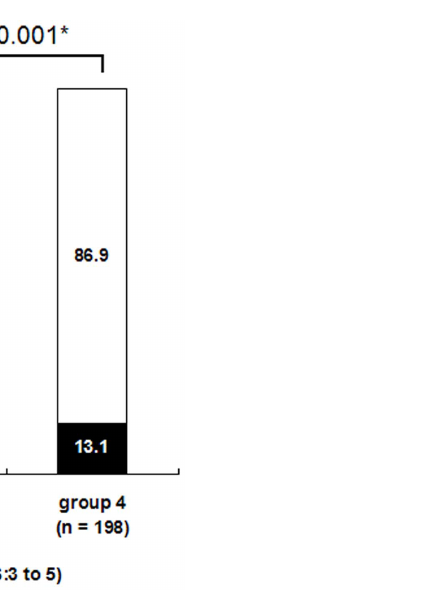
Figure 3. Percentage plot displaying percentages of unfavorable outcome in four subgroups with different levels of serum albumin. (group 1: , 25 g/L; group 2: 25 to 30 g/L; group 3: 30 to 35 g/L; group 4: $ 35 g/L) From group 1 to group 4, the percentages of unfavorable outcome (GOS: 1 to 2) displayed a downward trend (Cochran-Armitage trend test, P , 0.001), but only the difference between group 3 and group 4 was statistically significant. ( a after Bonferroni correction =0.008. * Statistically significant)